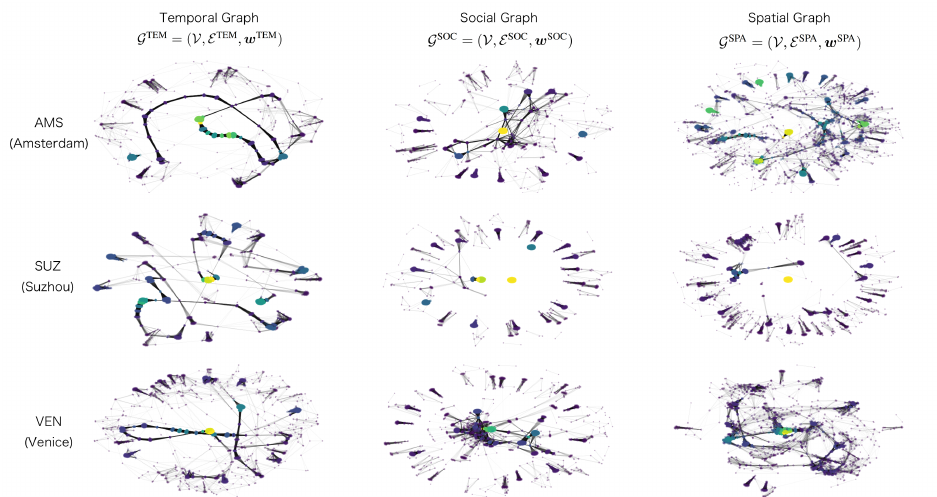
Figure A1. The subgraphs of the multi-graphs in each case study city visualized using spring layout in NetworkX. The node size and colour reflect the degrees, and link thickness the edge